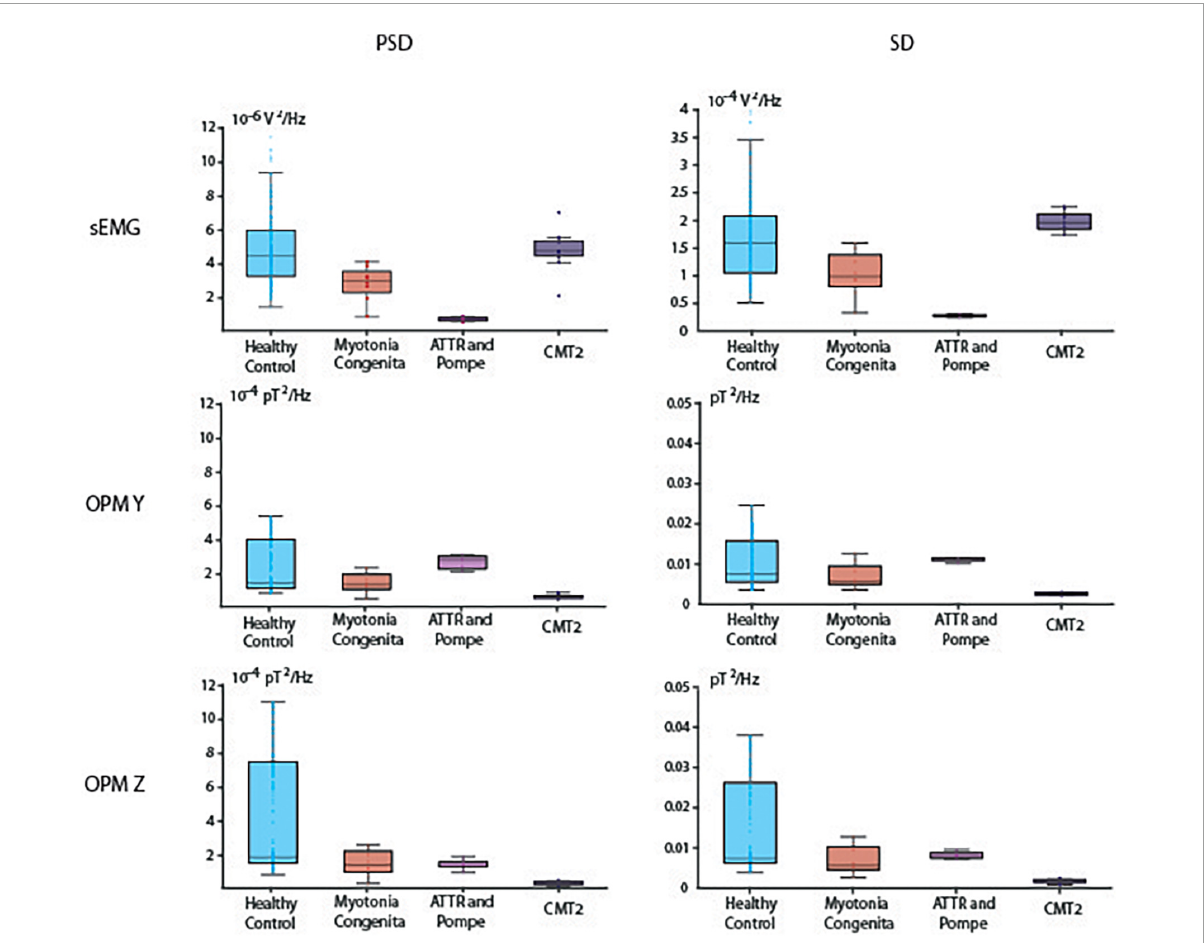
FIGURE3 Boxplots of power spectral density (PSD) in the interval of 20–100 Hz and the signal standard deviation (SD). Depicted are median, and the 25th and 75th